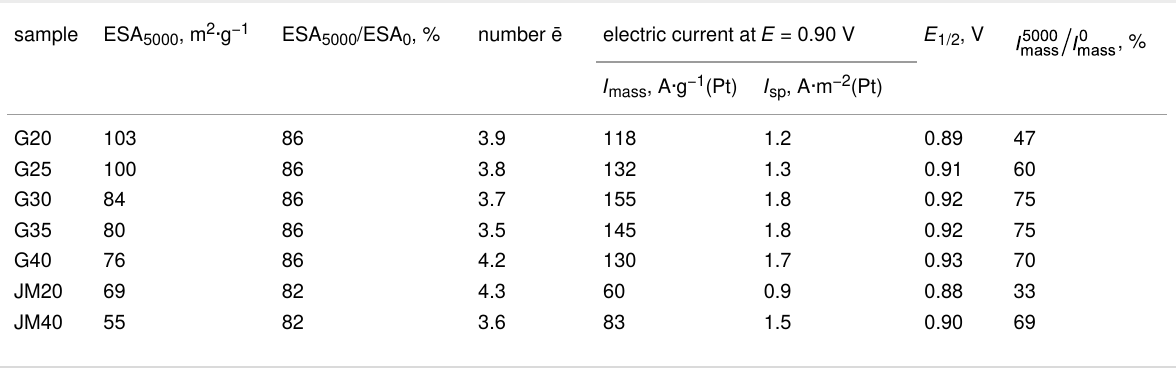
Table 3: Parameters characterizing the behavior of electrocatalysts upon the completion of the stress